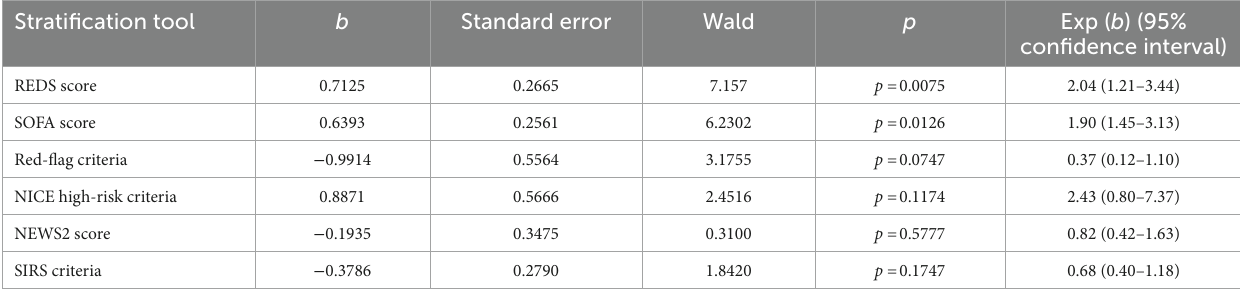
TABLE 5 Cox proportional hazard regression of the six risk-stratification tools in the population without specified * comorbidities. Stratification tool b Standard error Wald p